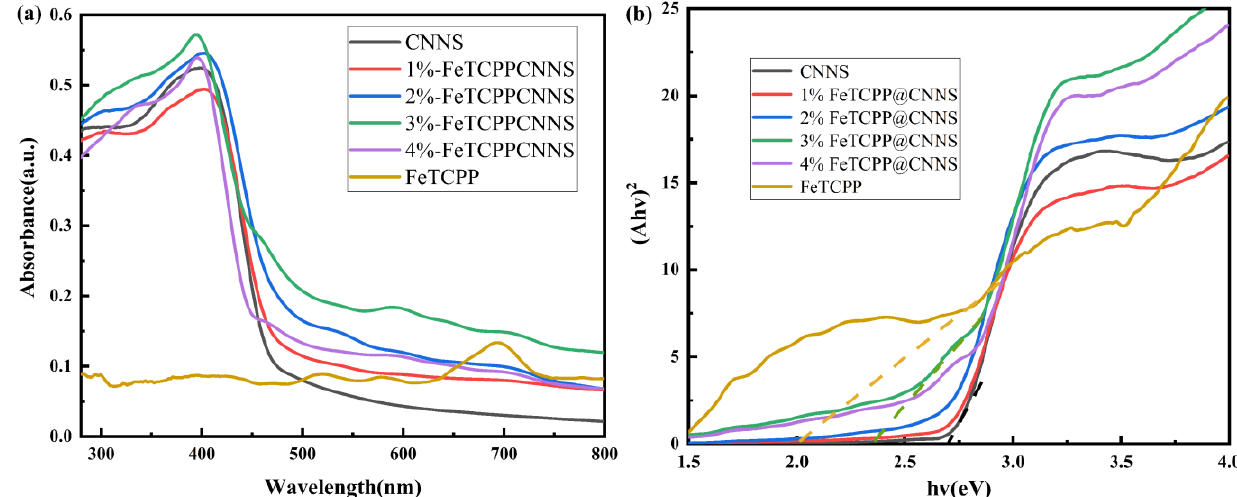
Figure 3. ( a ) UV-vis diffuse reflection spectra and ( b ) the band gap determined from Kubelka Munk transformation of CNNS, FeTCPP, and FeTCPP@CNNS composites.